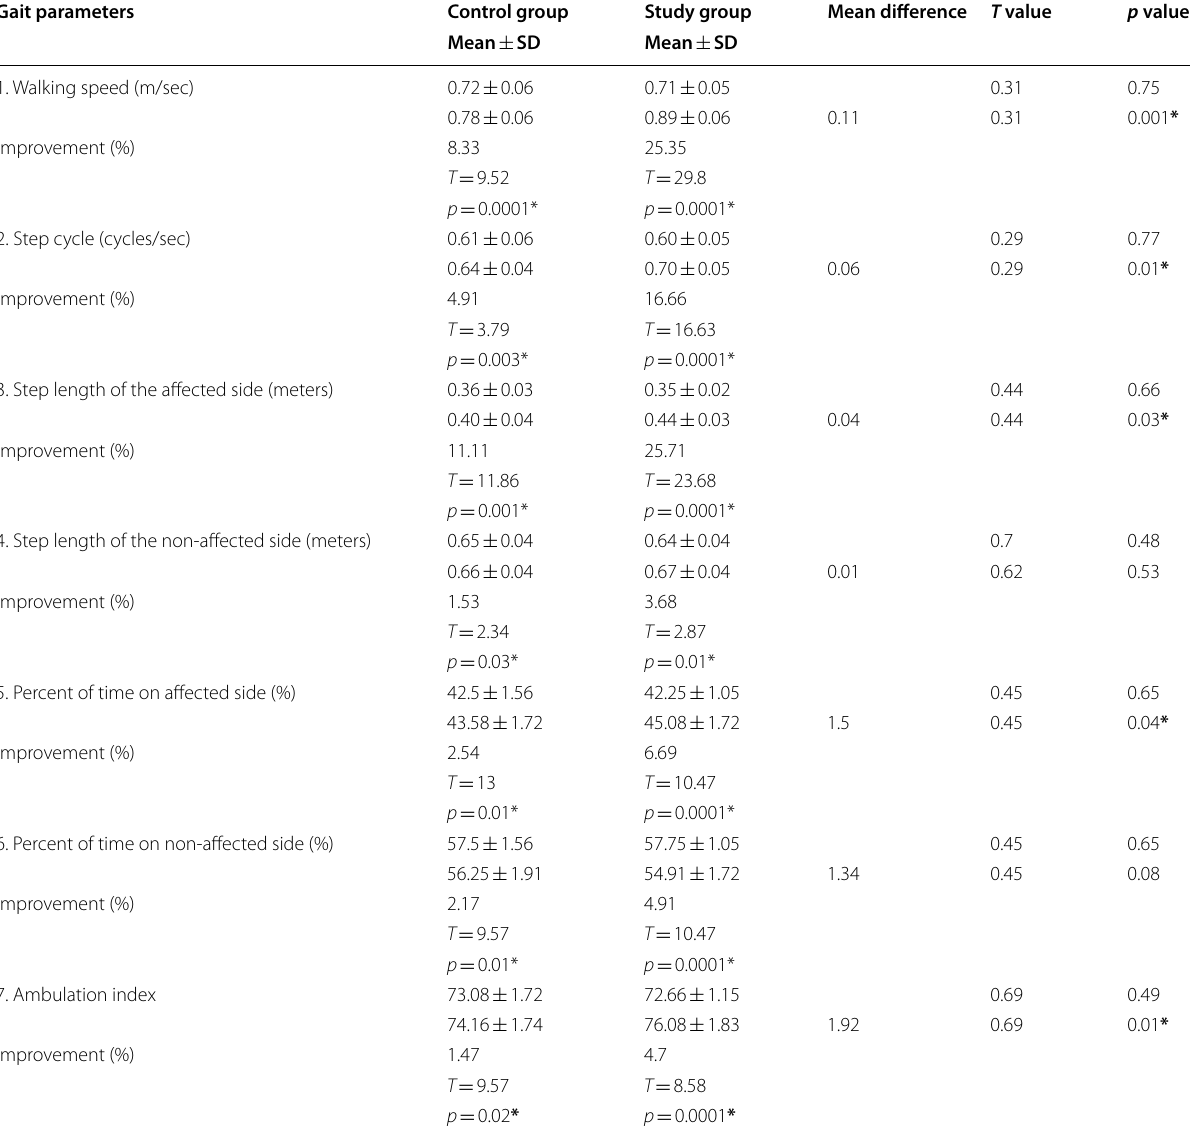
Table 2 Comparison of gait parameters within and between control and study groups pre- and